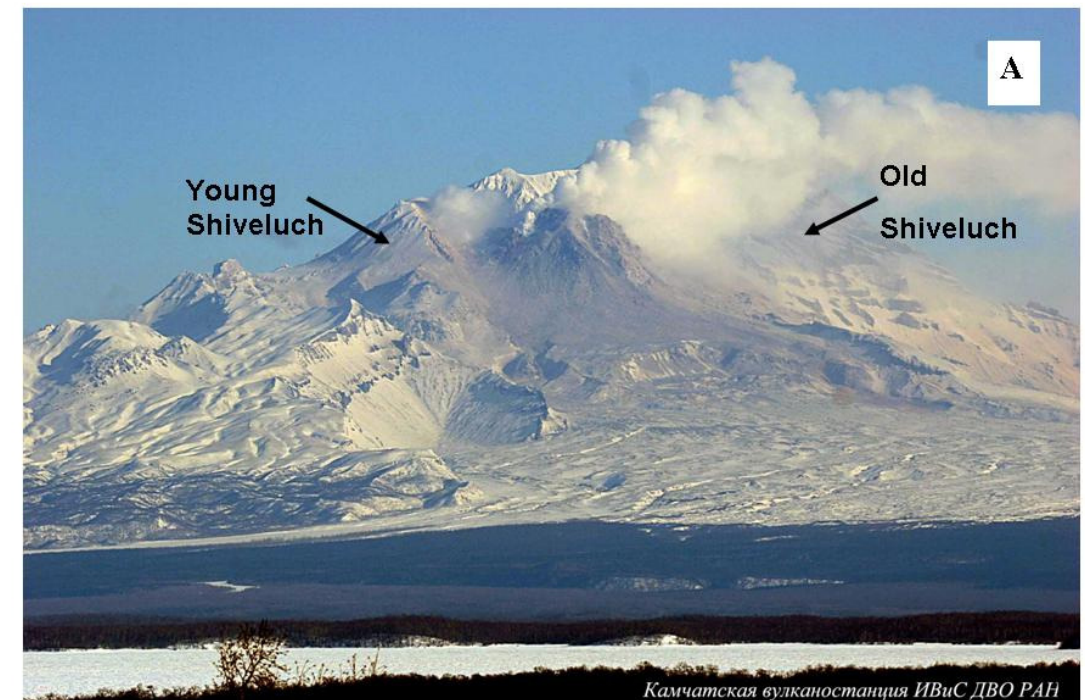
Figure 1. Field photographs of Shiveluch summit showing the southern flank of the volcano, the active lava dome, and the large PF deposits. (A) Ground-based photograph taken March 2009 by Y. Demyanchuk looking northeast. (B) Helicopter-based photograph of the 2005 PF deposit taken August 2005 by M. Ramsey looking east. Active dome at the time of the images is shown by the